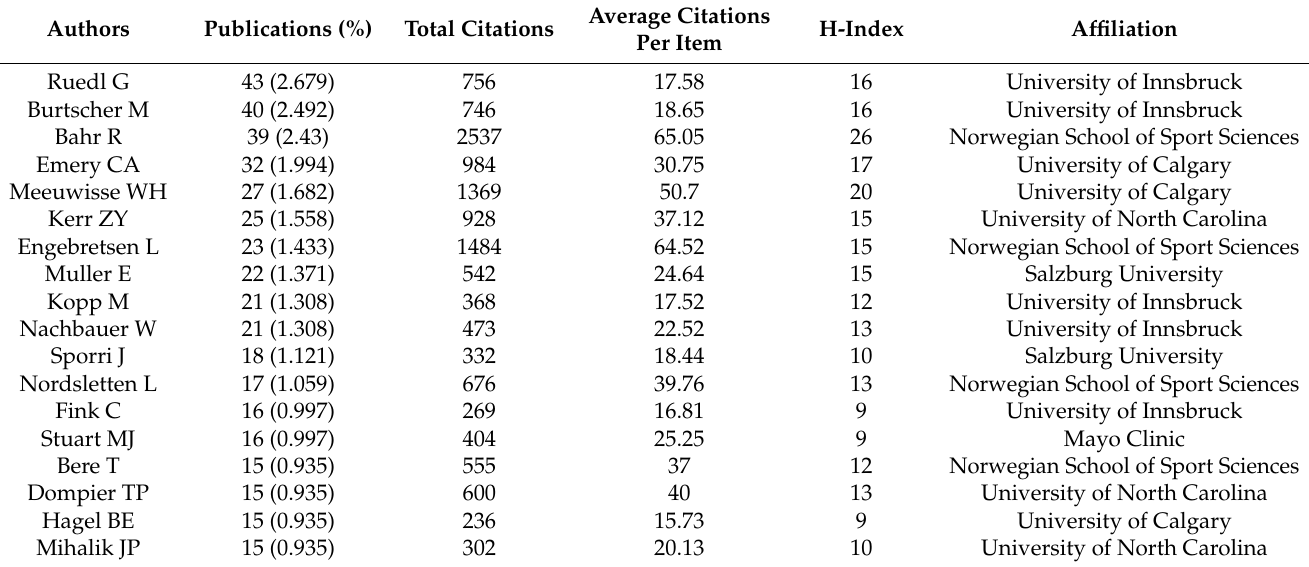
Table 3. The top 15 most published and cited productive authors in the top 3 research directions related to snow and ice sports